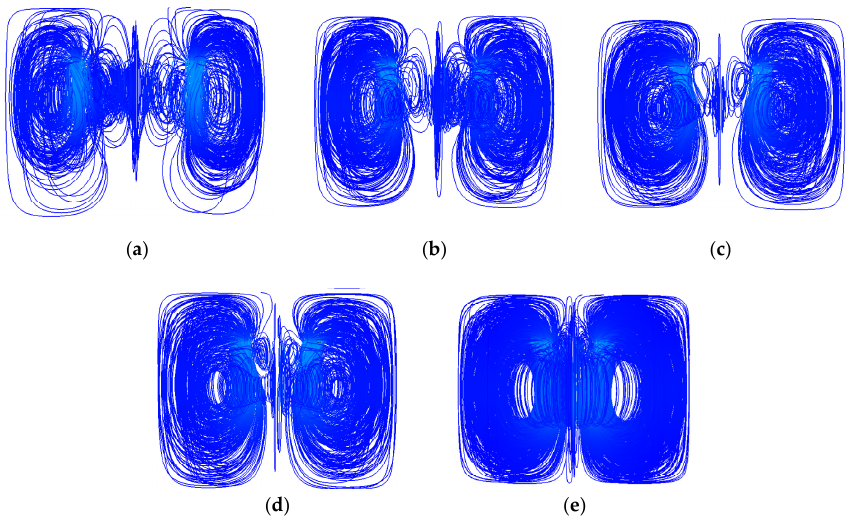
Figure 12. Streamline for octorotor in hover. ( a ) L / D = 1.8; ( b ) L / D = 1.6; ( c ) L / D = 1.4; ( d ) L / D = 1.2; ( e ) L / D = 1.0.